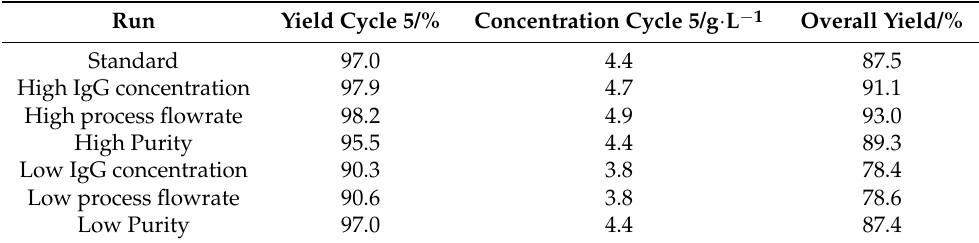
Table 4. Simulation results of iCCC with process disturbances after five cycles. Run Yield Cycle 5/%